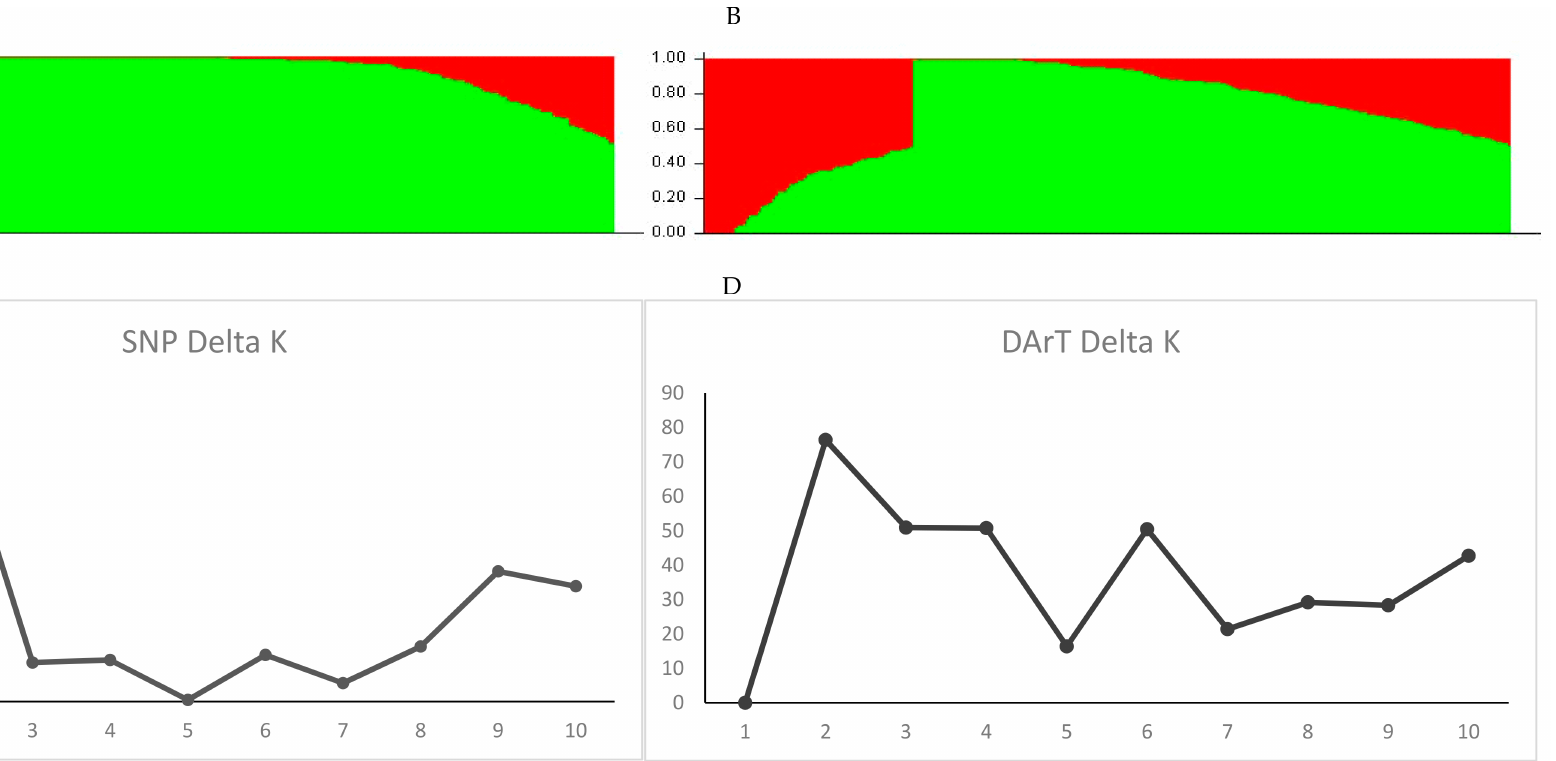
Figure 3. Population structure of the soybean accessions: ( A ) summary plot of estimates of Q for SNP markers; ( B ) rate of change of the likelihood ( ∆ K) for SNP markers; ( C ) summary plot of estimates of Q for DArT markers; ( D ) rate of change of the likelihood ( ∆ K) for DArT markers. The ∆ K shows a clear peak at the true value of